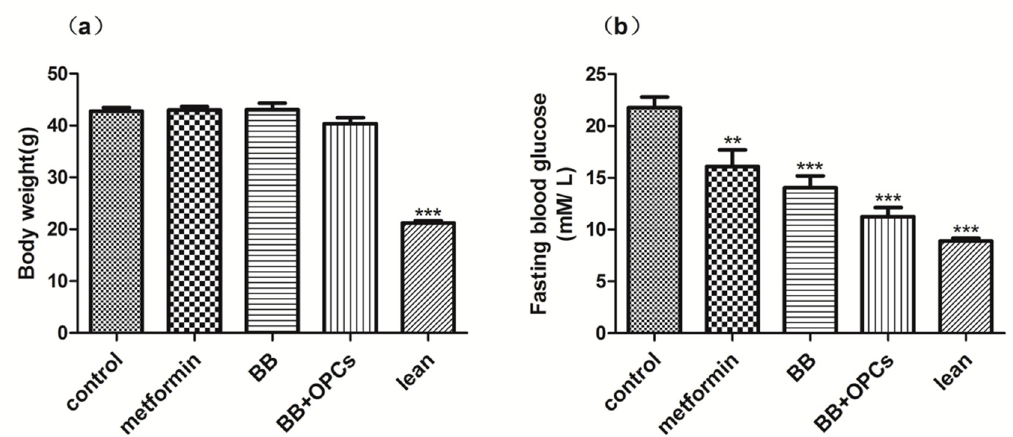
Figure 1. Effects of compounds on body weight and fasting glucose levels in db / db mice. Male C57BLKS/J db / db and db / m diabetic mice were left untreated or orally treated with metformin at 150 mg/kg, BB at 200 mg/kg, or BB at 200 mg/kg plus OPCs at 60 mg/kg, respectively. After treatment for 4 weeks, body weight ( a ) and fasting glucose ( b ) levels were measured. Data are presented as mean ± SEM of eight mice in each group. ** p < 0.01, *** p < 0.001 vs. untreated control.